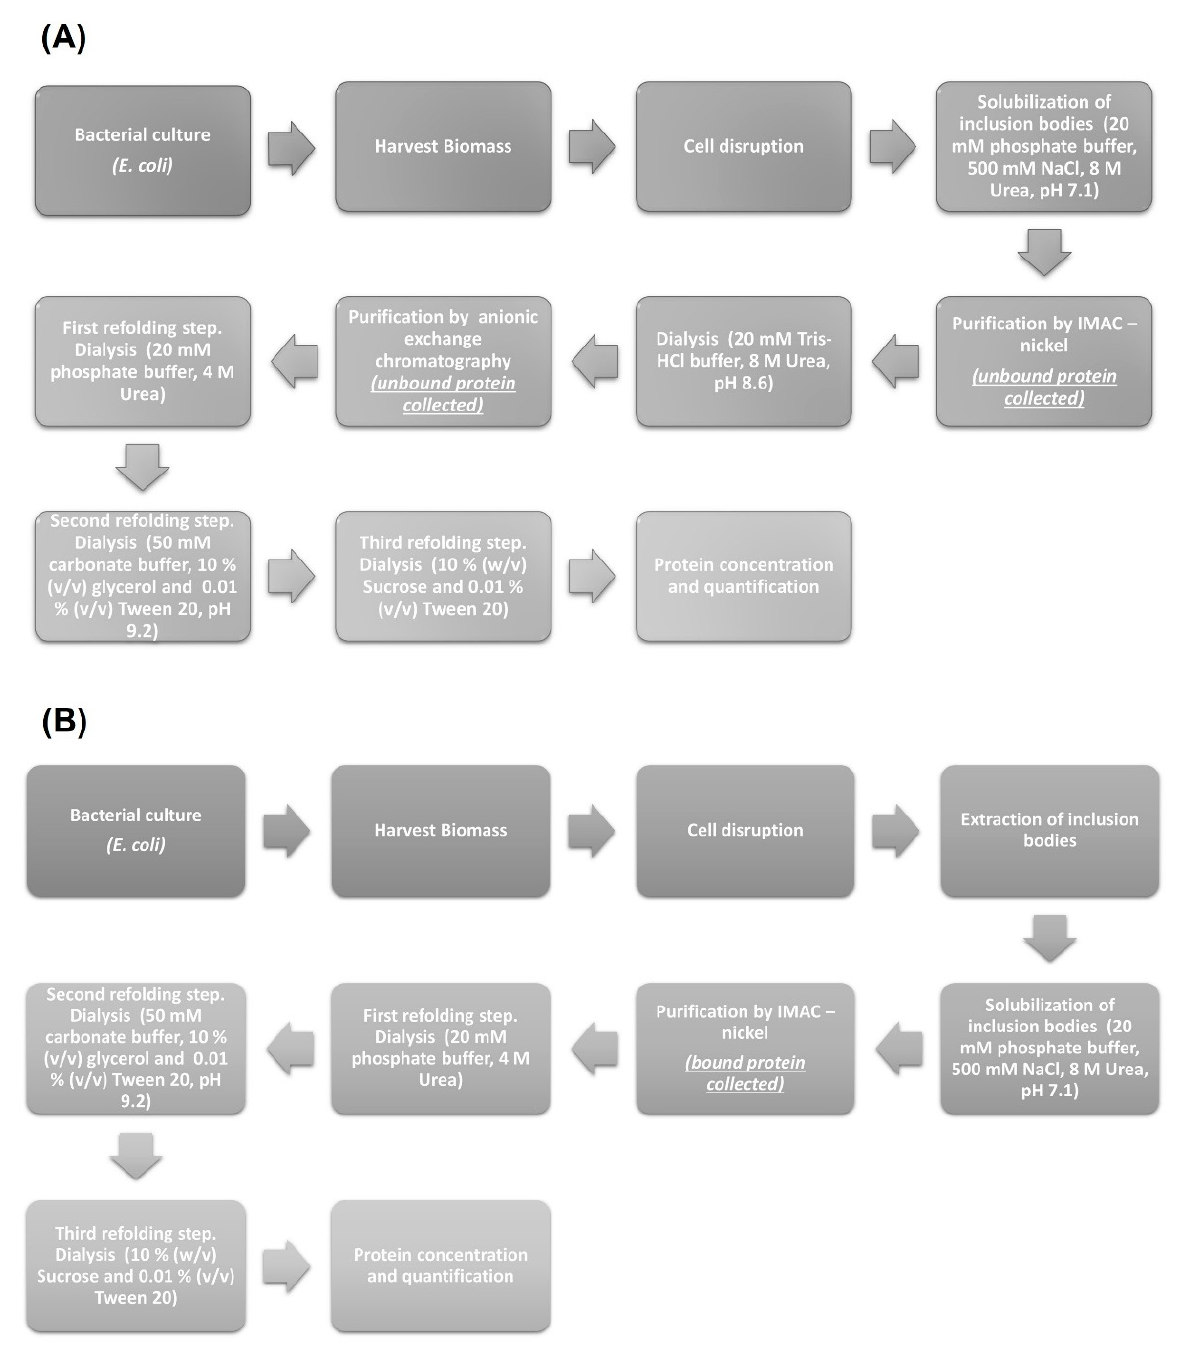
Figure 9 . Description of the steps followed in the methodology implemented for the purification of LTB-RBD antigens. ( A ) Protein purification workflow for LTB-RBD Wuhan, which has a His tag. ( B ) Protein purification workflow for LTB-RBD delta, which lacks tags.